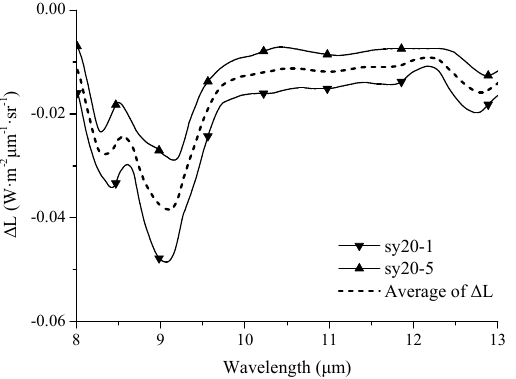
Figure 6. The radiance difference spectra after and before for the sandstone samples of local